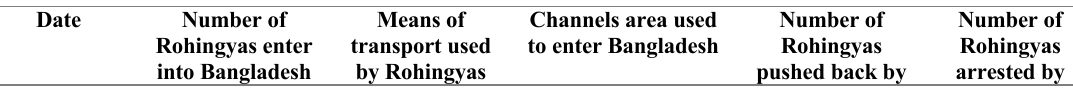
Table 3: A Report of Bangladesh’s Push Back Policy (June 2012- April